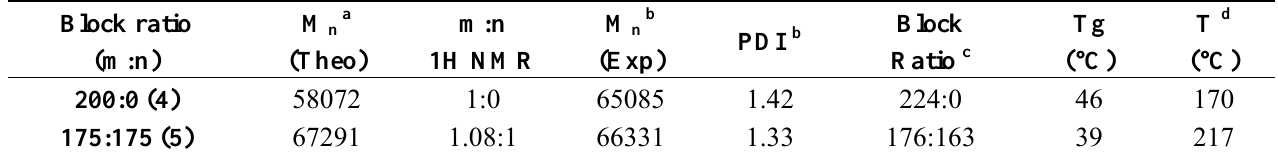
Table 1. Properties of the polymers.